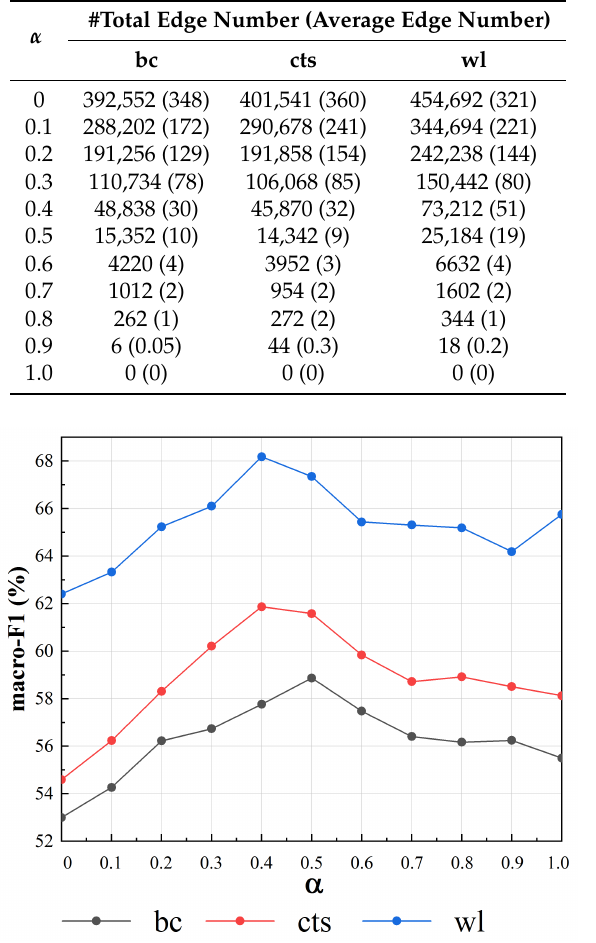
Table 4. The total and average number of edges whose fixed weights >0 under different values of α . The total number of edges is calculated based on the combination of all source and target domain data. The average edge number indicates the average number of edges in one sentence. None of the statistics include self-loop edges.